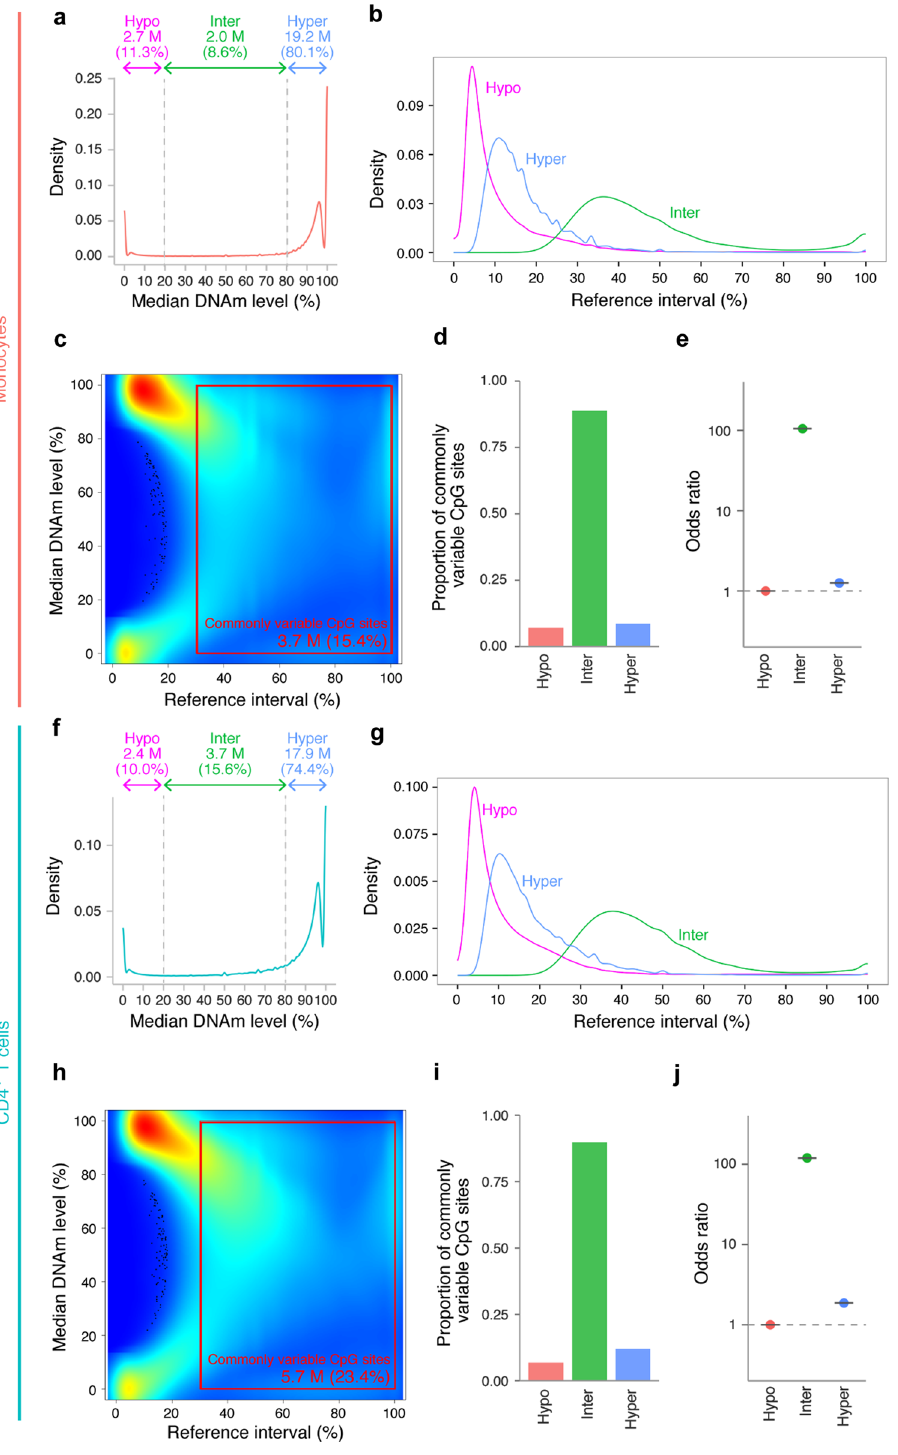
Fig. 5 Intermediately methylated CpG sites exhibit large DNAm variability. a Distribution of median DNAm levels in monocytes. b Distributions of reference intervals in monocytes for hypomethylated ( red ), hypermethylated ( blue ), and intermediately methylated ( green ) CpG sites. c CpG-density plot in monocytes. The x -axis represents reference intervals, and the y -axis indicates median DNAm levels. Density is indicated with a colour gradient, ranging from low ( blue ) to high ( red ). d Proportions of commonly variable CpG sites in monocytes. e OR in monocytes. The OR was estimated by comparing the proportion of commonly variable CpG sites in hypomethylated, hypermethylated and intermediately methylated CpG sites. The proportion of commonly variable CpG sites in hypomethylated CpG sites is used as the reference. The 95% reference intervals are represented as black lines . f Density plot of median DNAm level in CD4 + T cells. g Distribution of reference intervals in CD4 + T cells. h CpG-density plot in CD4 + T cells. i Proportions of commonly variable CpG sites in CD4 + T cells. j OR in CD4+T cells. Hyper hypermethylated CpG sites, Hypo hypomethylated, CpG sites Inter intermediately methylated CpG sites, M